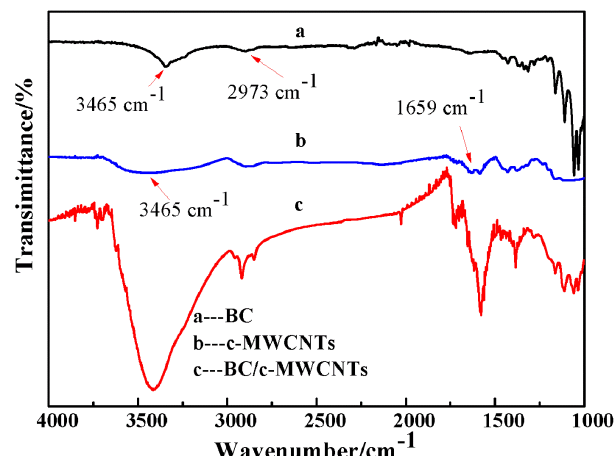
Figure 6. FTIR spectra of different composite. ( a ) BC; ( b ) c-MWCNTs; and ( c ) BC/c-MWCNTs composite.